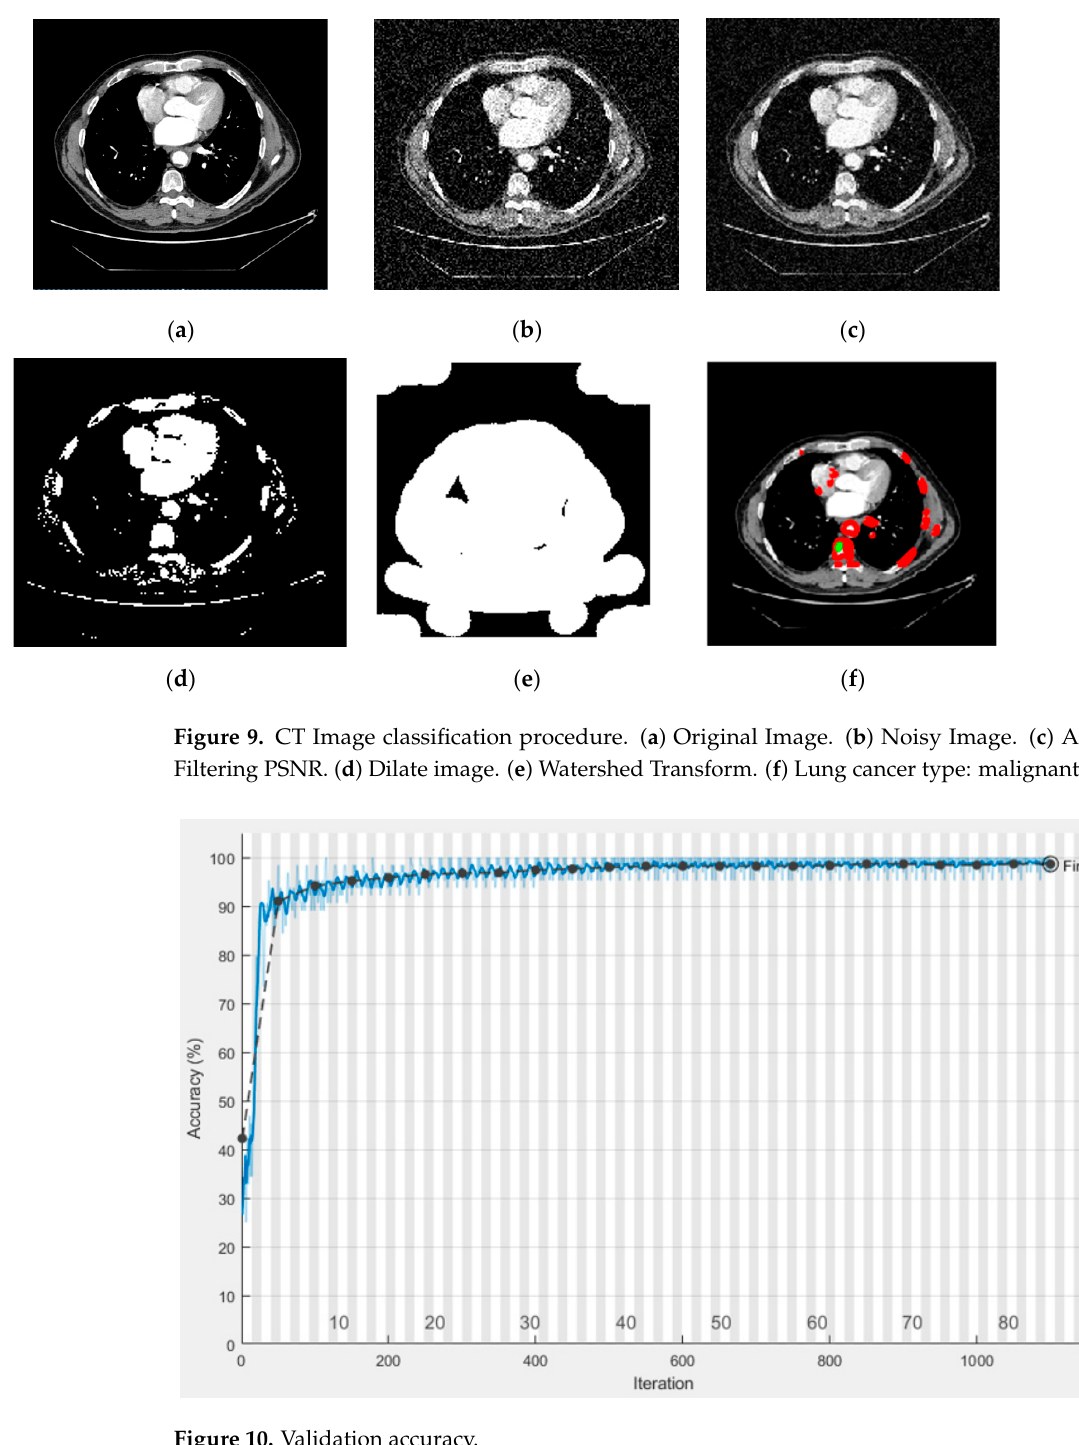
Figure 11. Validation loss. 5.3. Classification Results Results showed the following benefits of the suggested technique. The proportion of false positives decreased as precision increased. In the past, methods have been used that relied on a plethora of loud, useless characteristics, which may be seen as a weakness in the reliability of the final product. In contrast to earlier research, which only included two, we included three. The accuracy of the suggested approach was 98.96%. Our three types of test data were successfully predicted using this trained TL model. The results of the prediction for varying PSNR levels across the three classes are shown in Table 4, the out- comes for each class, while our tested data included 910 scans.